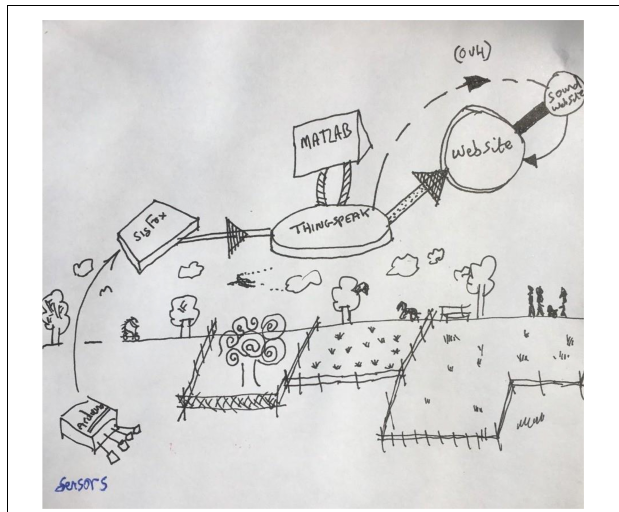
FIGURE 4 | Outline concept sketch for connecting school to